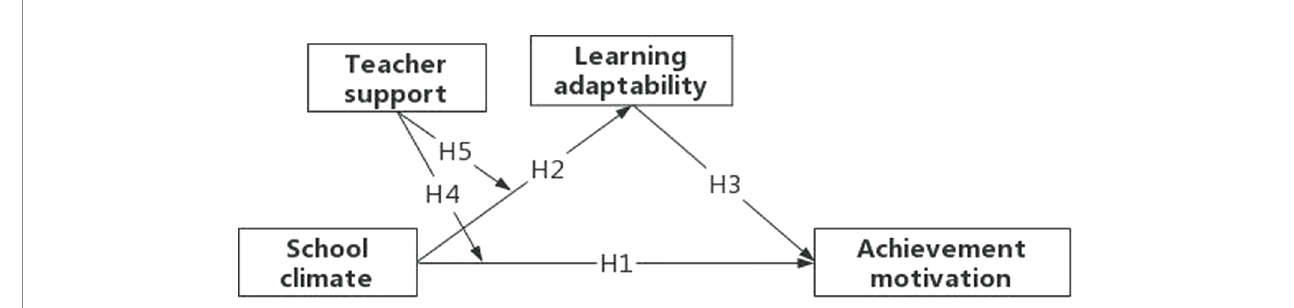
FIGURE 1 Conceptual model